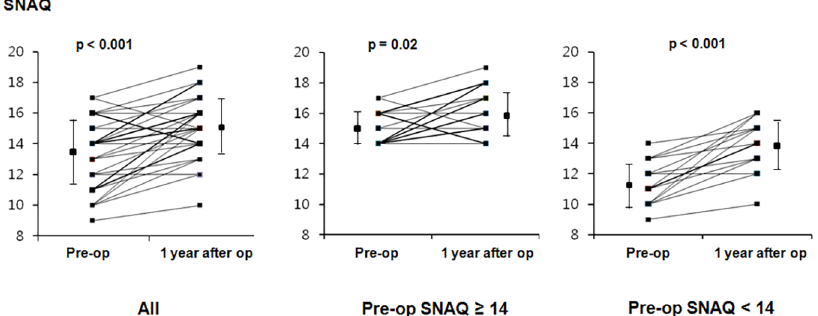
Fig 1. Changes in short nutrition assessment questionnaire (SNAQ) before and after mitral valvular surgery (SNAQ score < 14 has been reported to be a significant risk for weight loss > 5% within 6 months). Paired t-test or Wilcoxon signed rank test (non-parametric).